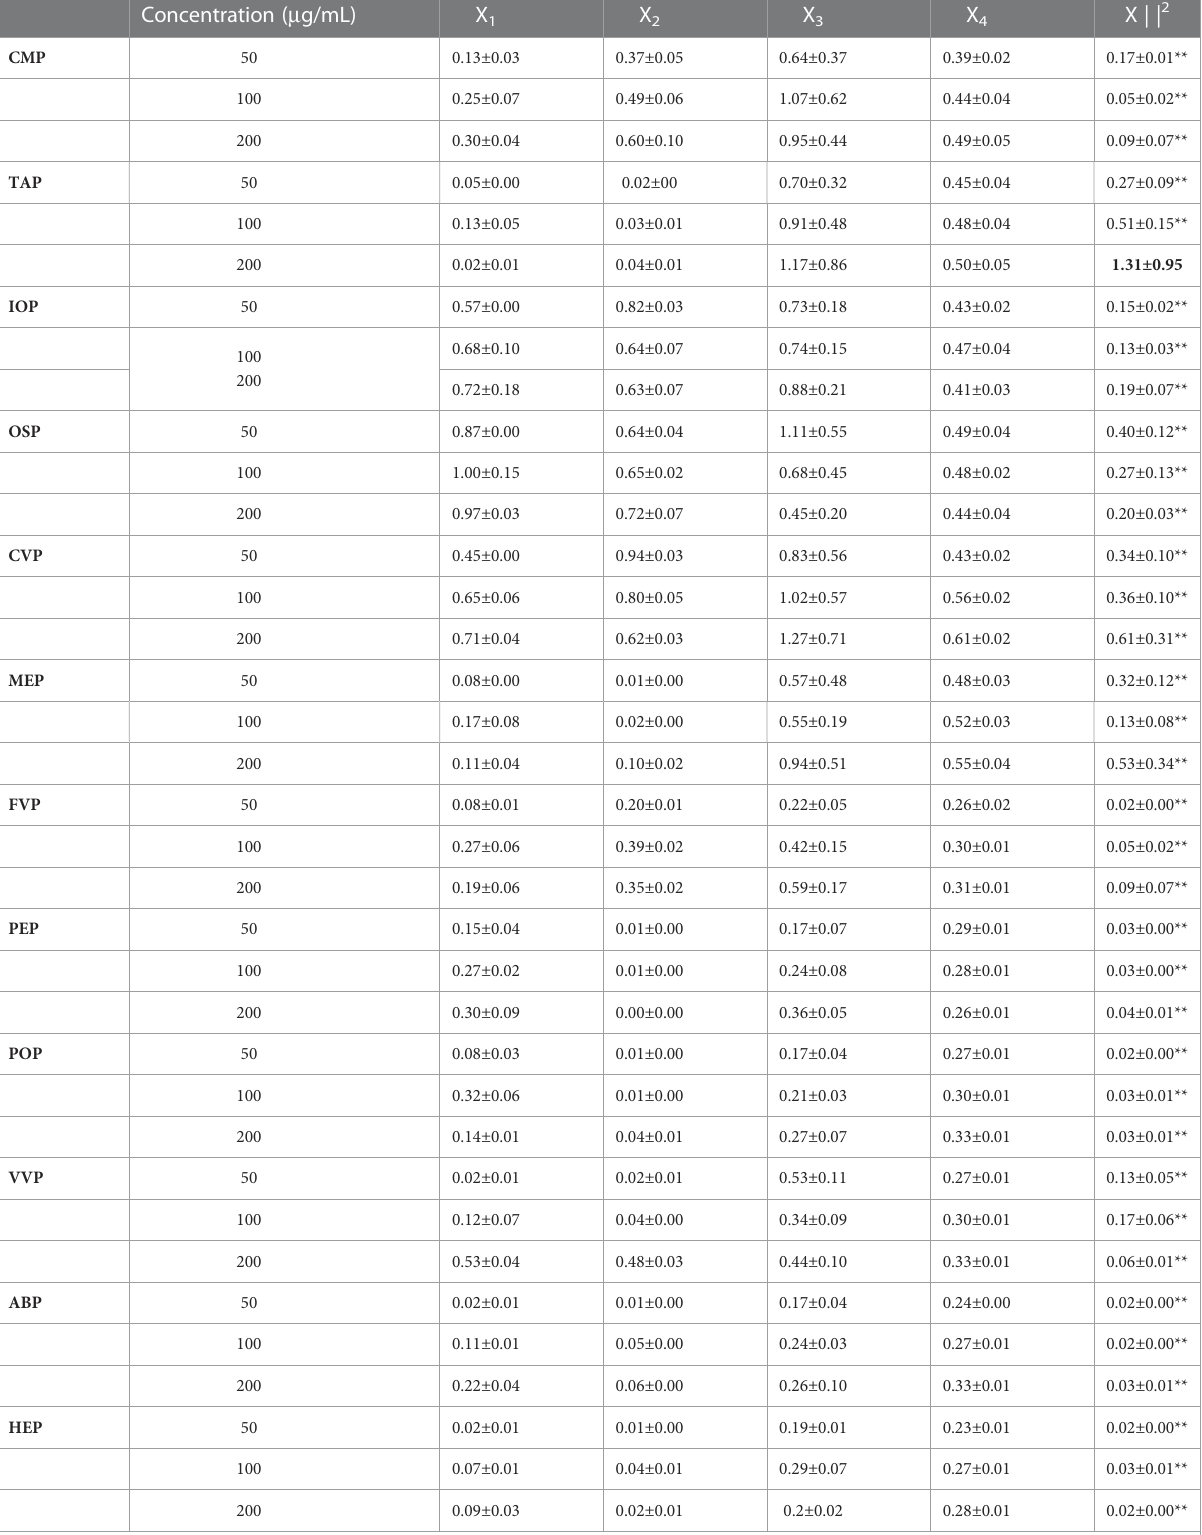
TABLE 4 Comparison of the immune activity of twelve edible mushroom proteins (n =